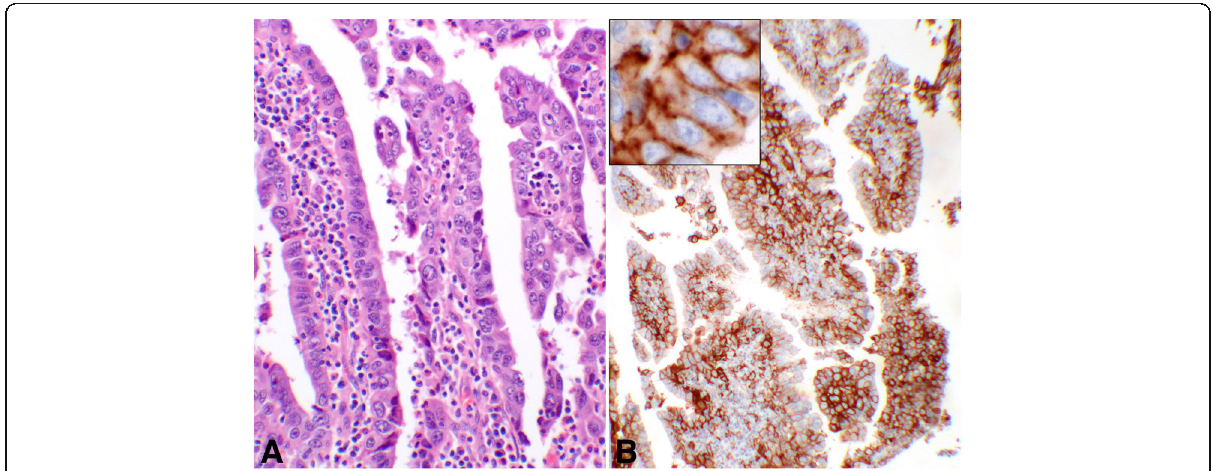
Fig. 4 Score 2 in endocervical adenocarcinoma. An example of Score 2b endocervical adenocarcinoma of the cervix with PD-L1 reaction involving 90% of the epithelial tumor cells (#12, Table 5). a shows the hematoxylin & eosin stain of the glandular structures with atypical epithelial cell lining and inflammatory stromal core (objective 20×). b demonstrates the membrane reaction for PD-L1 with 2+ intensity involving the epithelial tumor cells, many at cross section (objective 10×). The inset shows the circumferential membrane staining of the tumor cells for PD-L1 at a higher magnification (objective